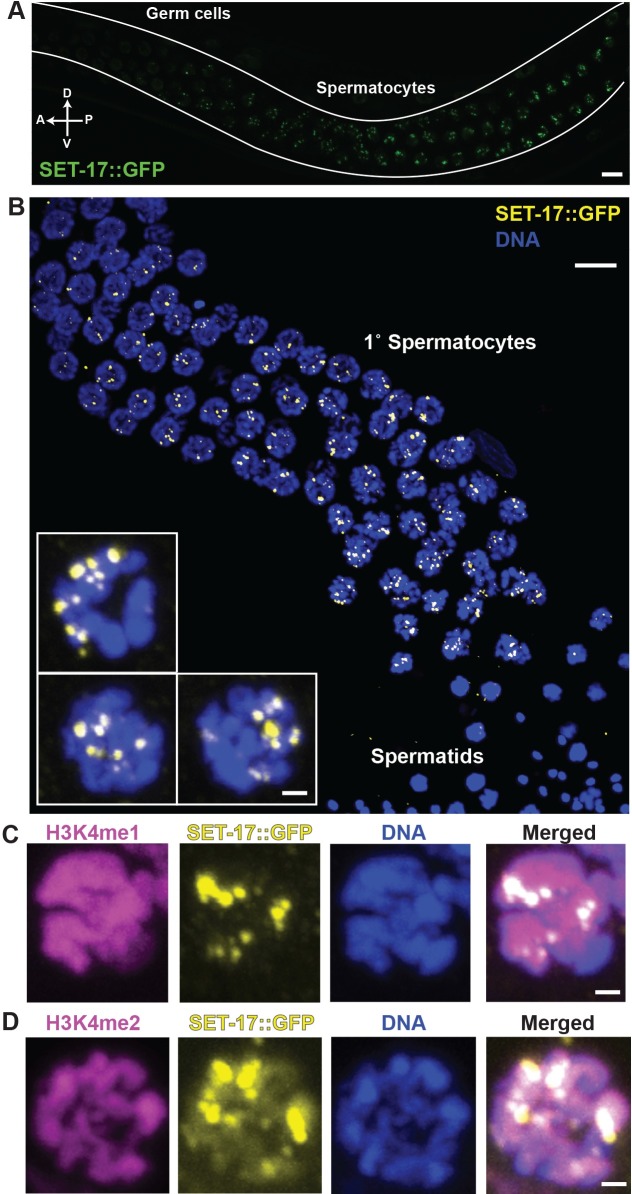
SET-17 is expressed in the nuclei of primary spermatocytes and enriched in chromatin-associated foci.A) Confocal imaging of a longitudinal section showing SET-17::GFP expression in germ cells and spermatocytes of an adult male germline. White lines delineate the gonad. Scale bar, 10 μm. A, anterior; P, posterior; D, dorsal; V, ventral. B) Representative Z-axis projection of confocal images of extruded and formaldehyde-fixed male germlines expressing SET-17::GFP and stained for GFP by immunofluorescence (yellow). DNA stained with DAPI (blue). Scale bar, 10 μm. Inserts, higher magnification views of individual representative nuclei. Scale bar, 1 μm. C) & D) Representative Z-axis projection of primary spermatocyte nuclei of males expressing SET-17::GFP. Nuclei were stained by immunofluorescence for GFP and H3K4me1 C) or H3K4me2 D), respectively. DNA, DAPI. Scale bar, 1 μm.